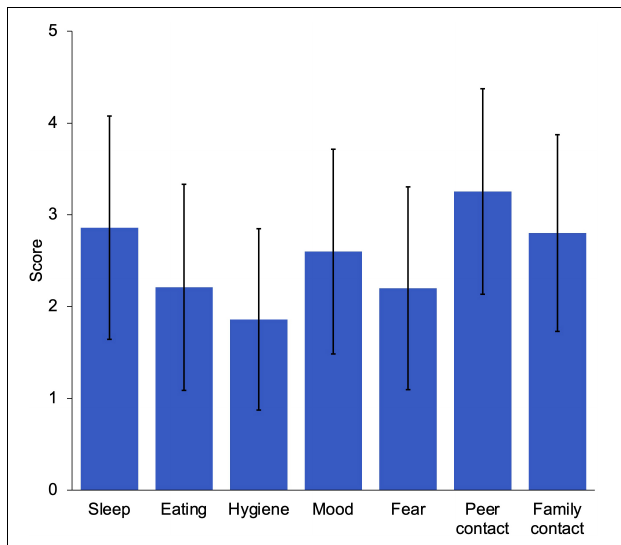
FIGURE 1 | Mean scores and standard deviation in change of children’s